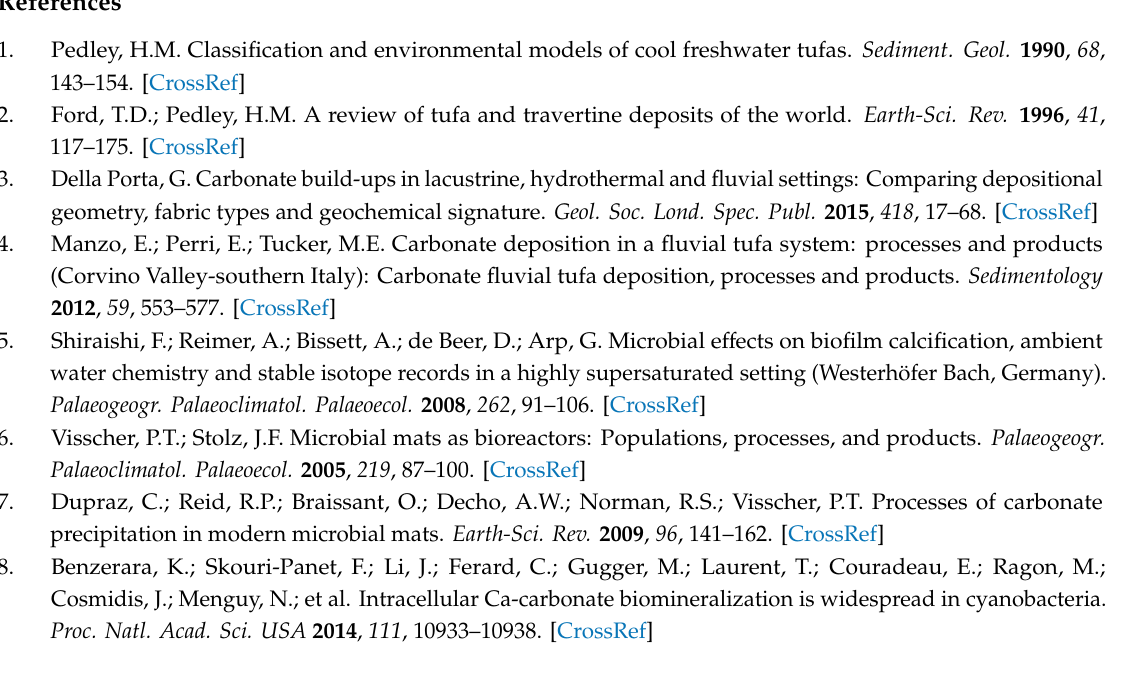
Table S1: Measurements of major physicochemical parameters of studied